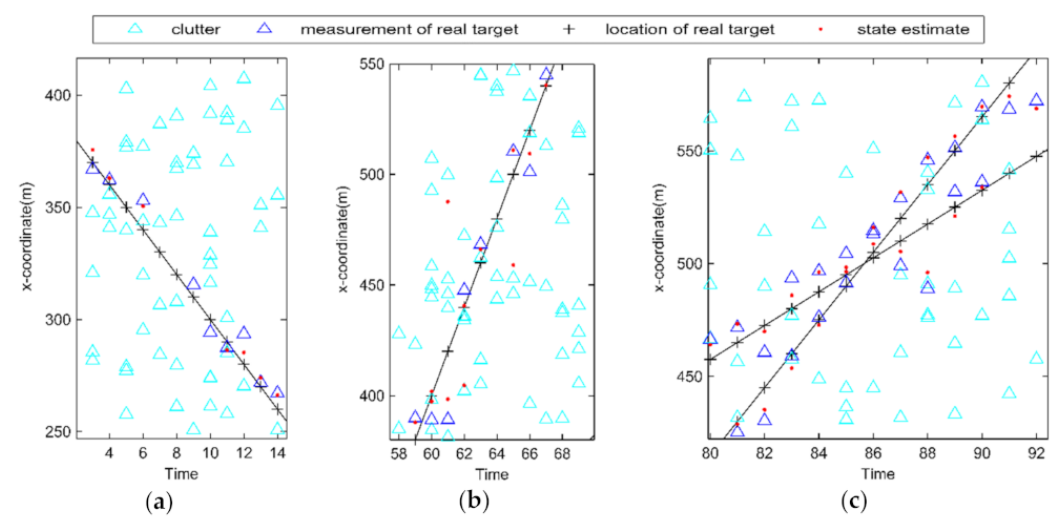
Figure 2. Phenomena affecting track continuity of the basic GM-PHD filter. ( a ) detection uncertainty; ( b ) false state estimates; ( c ) closely spaced